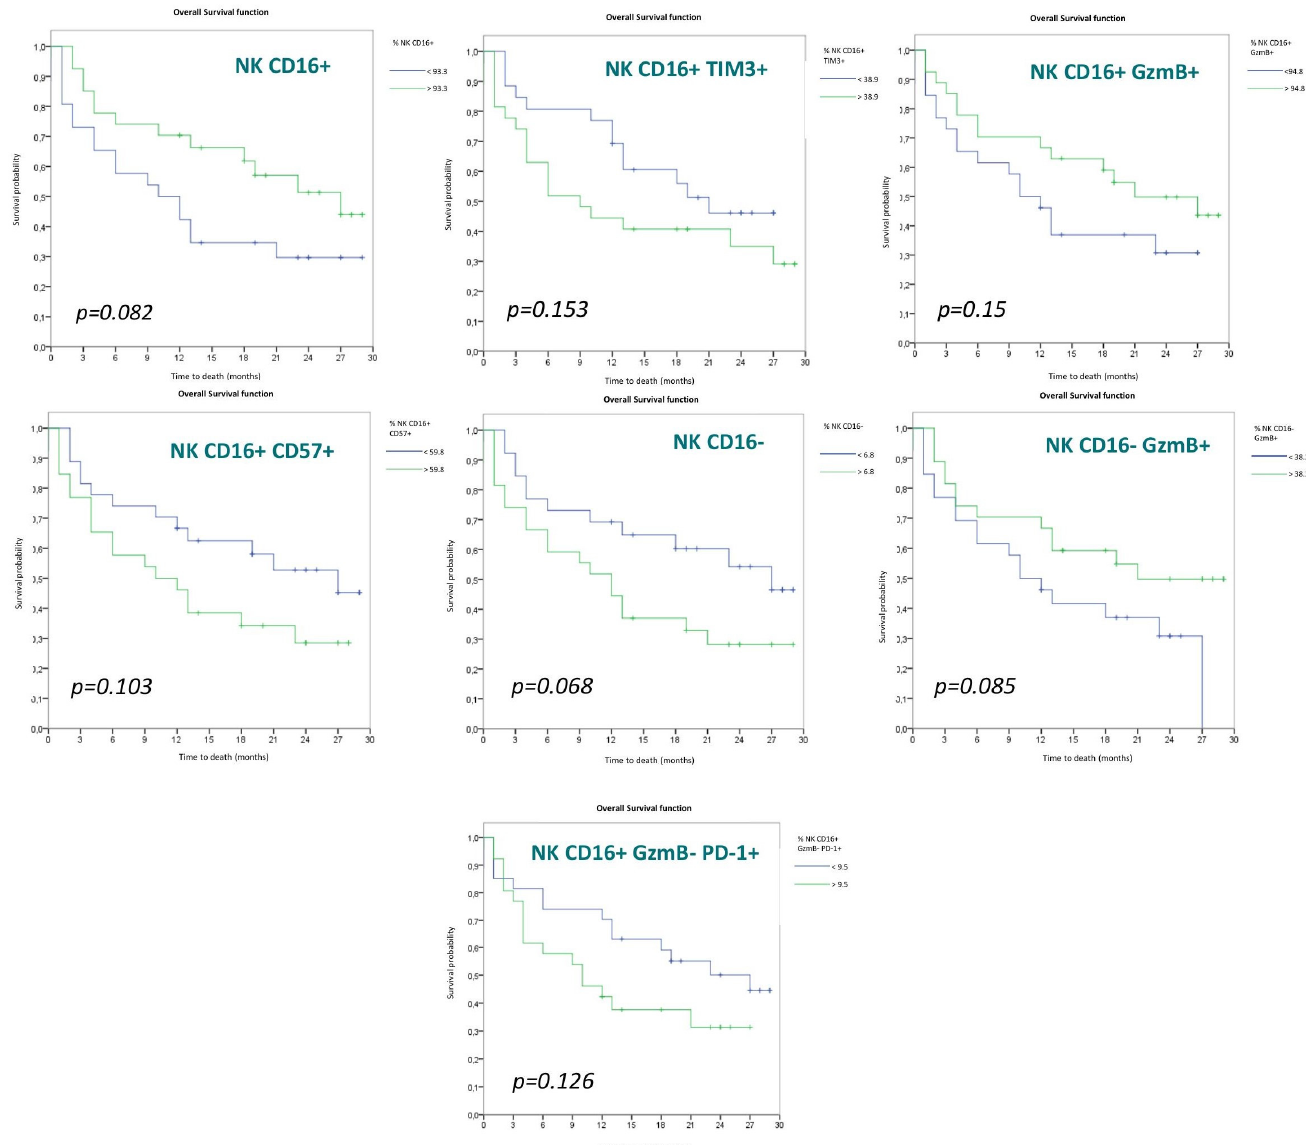
Figure 5. Overall survival curves according to NK populations.